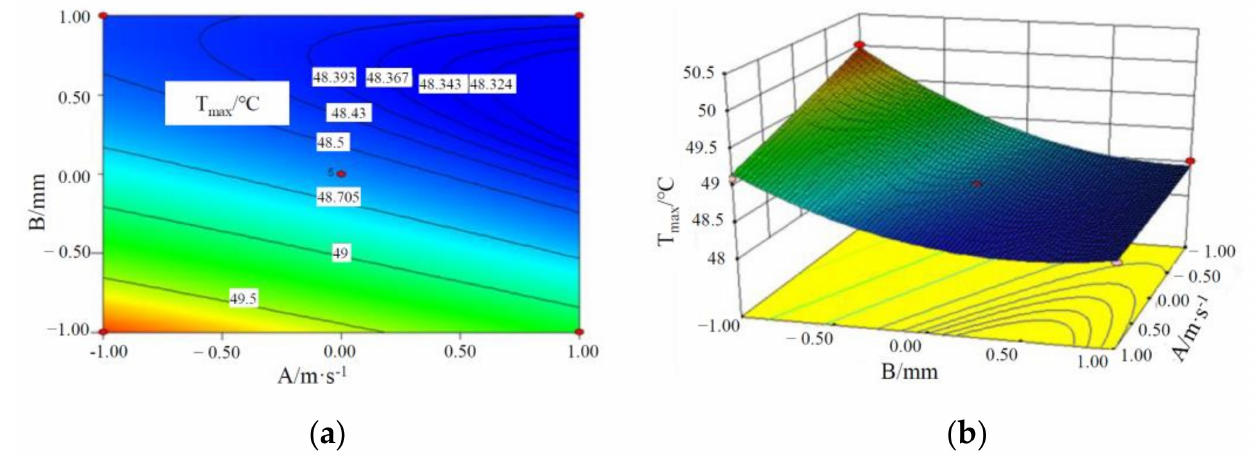
Figure 2. Contours and response surface of the impact of liquid flow rate and CPCM thickness on the maximum temperature. ( a ) Contours; ( b ) response